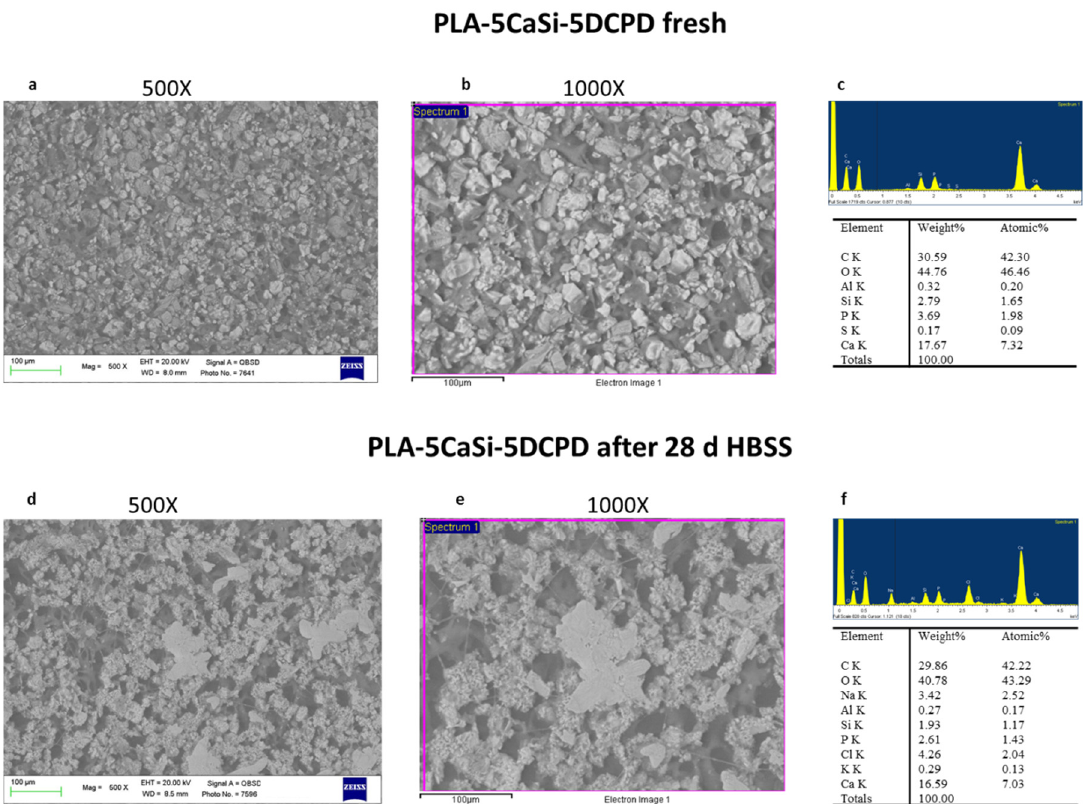
Figure 4. SEM-EDX microanalysis before and after the immersion in HBSS of PLA-5CaSi-5DCPD scaffold. Fresh scaffolds revealed a homogeneous mineral layer, partially occluding the superficial scaffold pores (size of approx. 20 µm). EDX confirmed the presence of CaSi and DCPD mineral powders. After 28 days immersion in HBSS, the scaffold surface resulted more irregular: in the majority of cases, the surface area was completely covered by a compact mineral later, while in few cases, the surface revealed larger pores (ranging from 20–100 µm), attributable by PLA initial degradation. EDX revealed a moderate increase of Ca and P (from CaP layer) and a slight increase of Si (from the matrix degradation).